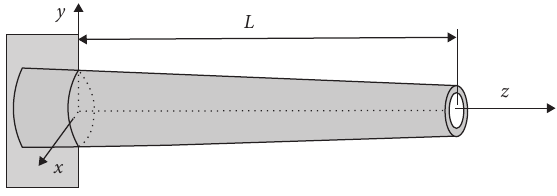
Figure 1: Model of tapered composite boring